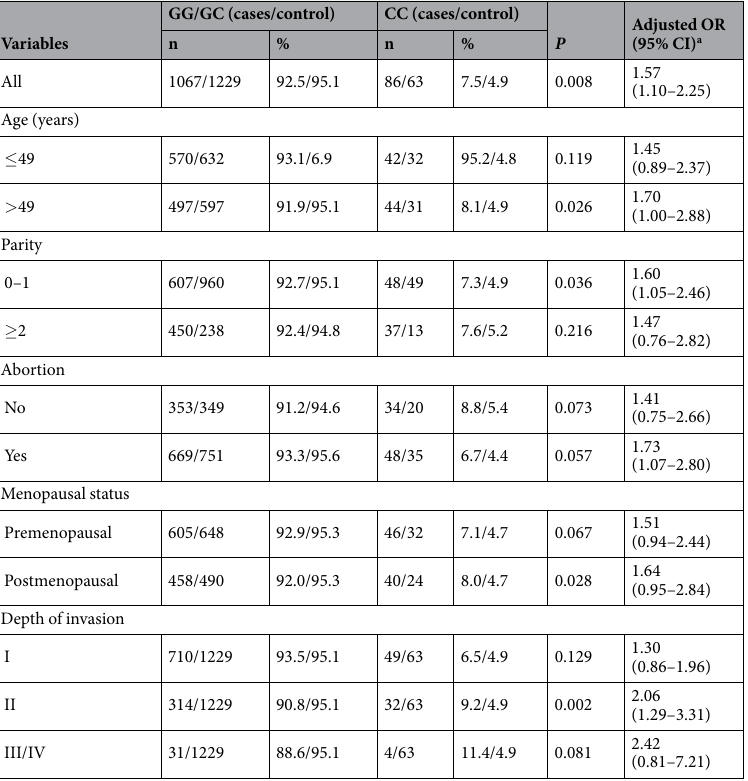
Table 2. Stratified analysis of rs7958904 genotypes and CC risk by selected variables. a Adjusted for age, parity, and menopausal status in logistic regression